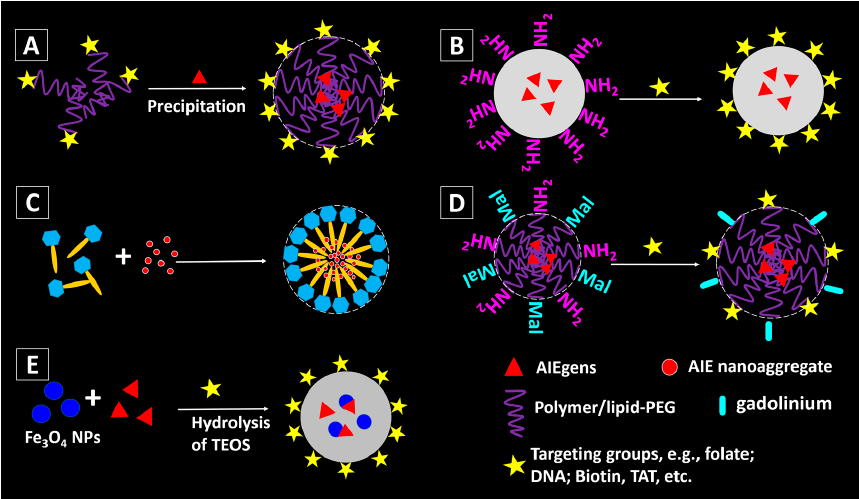
Figure 4. Methods for fabricating functionalized AIEgen-based nanomaterials: ( A ) with pre-modified building matrixes; ( B ) surface modification of the amino groups-decorated AIE/SiO 2 NPs [36]; ( C ) AIE aggregates can be naturally encapsulated inside the saponin micelles [47]; ( D ) dual functionalization of the AIE NPs by post-modification [48]; ( E ) incorporation of magnetic component (e.g., Fe 3 O 4 ) into AIE-SiO 2 NPs [49].